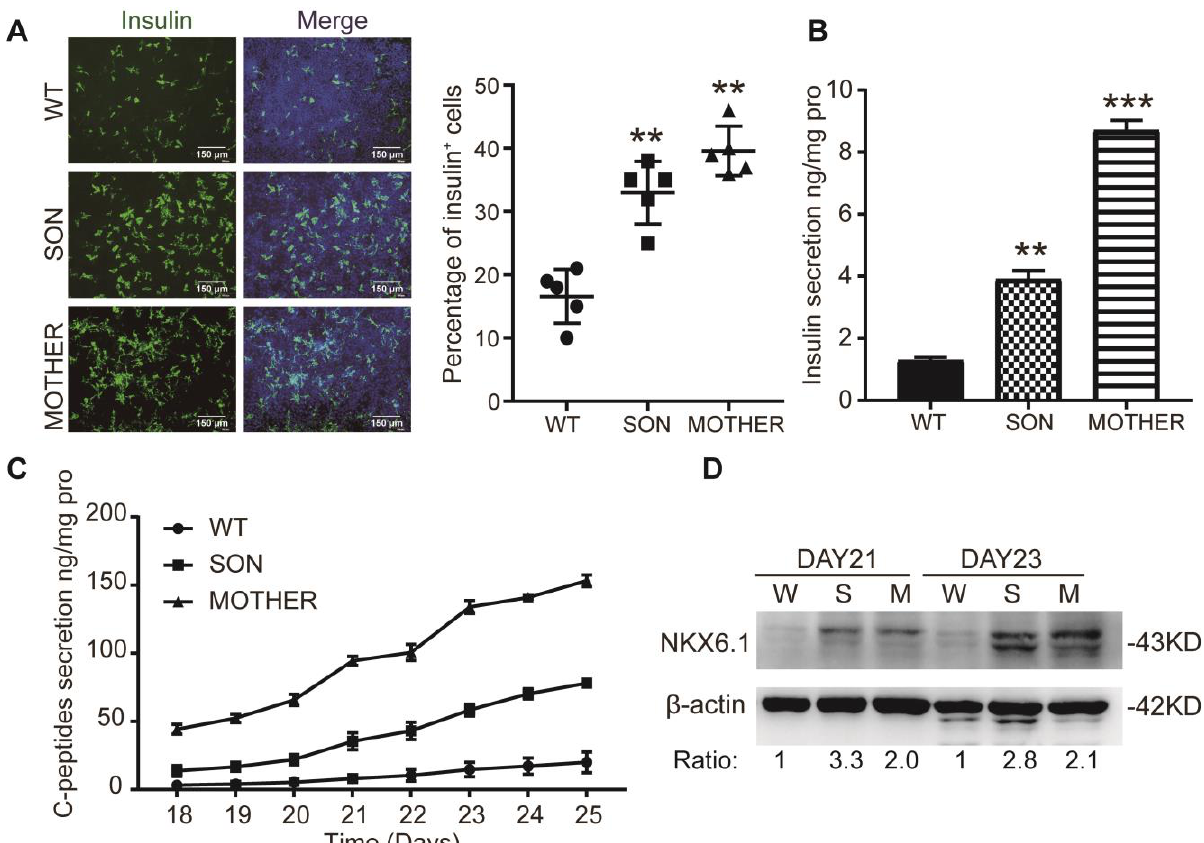
Figure 1. Significant increased percentage of insulin-positive cells and insulin production in MEN1-IPCs. ( A ) Insulin expression in IPC stage, n = 5, scale bar: 150 µ m. ( B ) ELISA measurements of secreted insulin in IPC stage, n = 3. ( C ) The secretion of C-peptides during the differentiation process, n = 3. ( D ) The expression of NKX6.1 in IPC stage with the number below representing the fold change after being normalized, n = 3. W-WT, S-SON, M-MOTHER. The bar plots ( n ≥ 3 wells per group) are mean ± SEM. ** p < 0.01, *** p < 0.001.